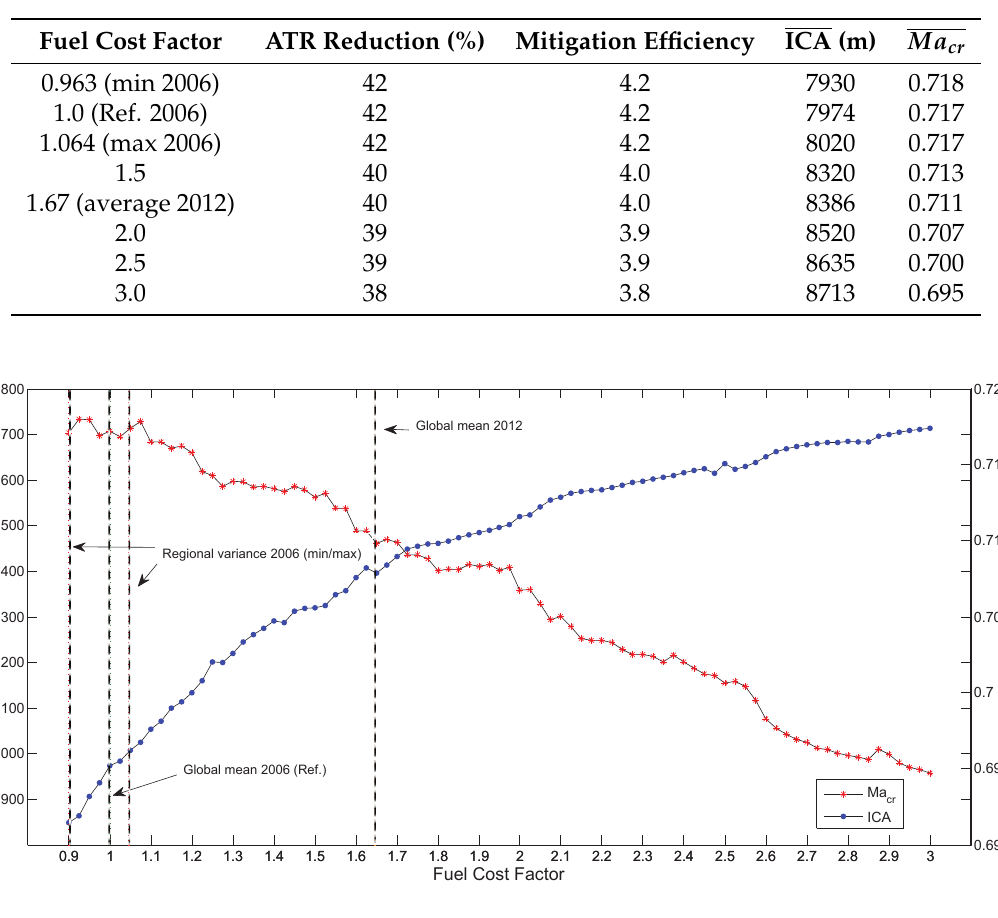
Figure 14. Cruise conditions (average ICA, Ma cr ) at COC rel , all = 1.1 as a function of fuel